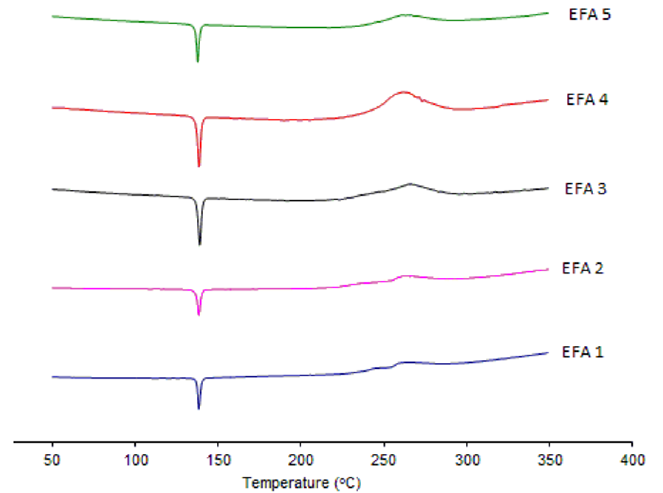
Figure 5 . DSC curves of efavirenz batches 1 to 5 (EFA 1 to